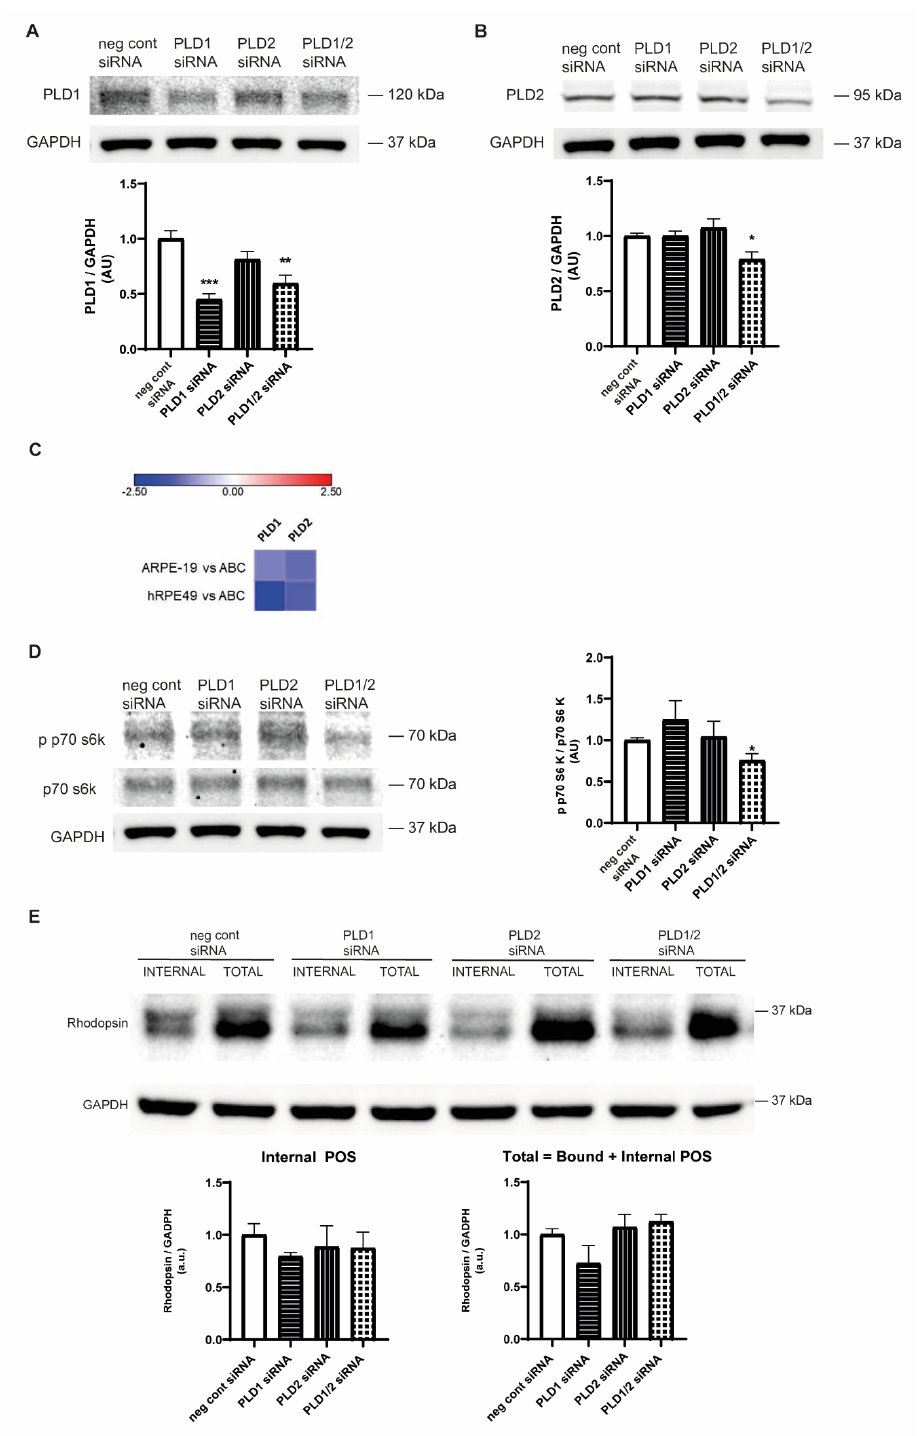
Figure 3. PLD1 and PLD2 expression and silencing in ABC cells. Confluent ABC cell cultures were transiently transfected for 48 h with PLD1 siRNA, PLD2 siRNA, or PLD1 plus PLD2 siRNAs, as described in the Materials and Methods section. WB assays were performed to detect PLD1 ( A ), PLD2 ( B ), and GAPDH. For A and B, bar graphs show the densitometry values of PLD1/GAPDH and PLD2/GAPDH expressed as arbitrary units (AU) with respect to control conditions (neg control siRNA). ( C ) Heatmap from RNAseq analysis of ARPE-19 cells and hRPE49 cells compared to ABC showing PLD1 and PLD2 expression. Analysis was performed using ABC cells as control (fold change). Red means the pathway is upregulated when compared to ABC, while blue means it is downregulated. Data are detailed in Supplementary Table S1. ( D ) Effect of PLD silencing on